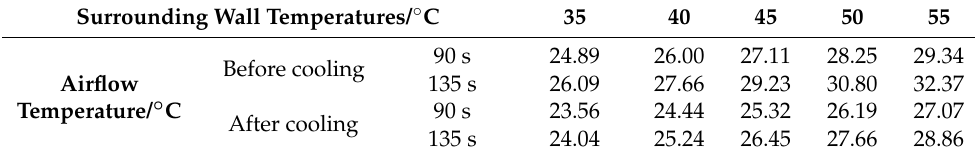
Figure 11. Variation of the airflow temperature at measurement point 3 under different surrounding wall temperatures. wall temperatures. Table 5. Temperature of measuring point 3 under different surrounding wall Table 5. Temperature of measuring point 3 under different surrounding wall temperatures.